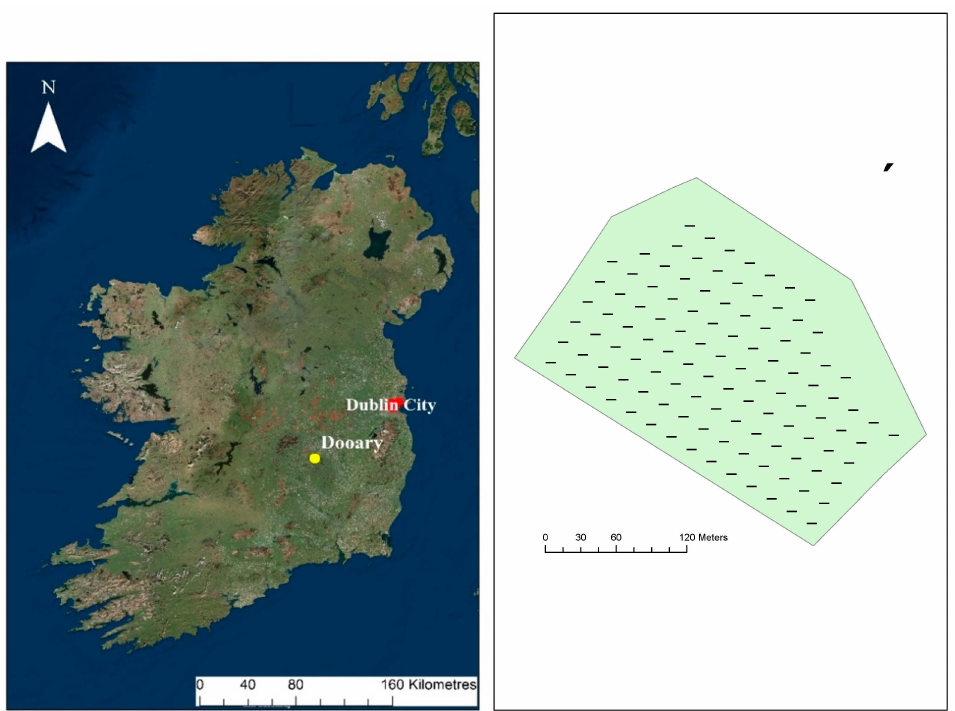
Figure 1. The site at the Dooary forest in central Ireland ( left ) where the soil samples were collected and the soil sampling locations within the study area ( right